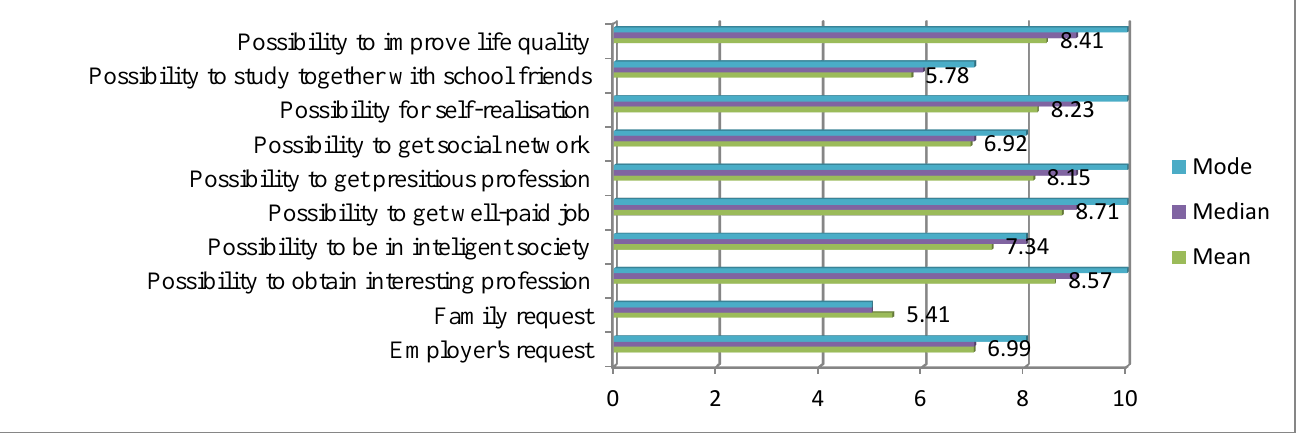
Fig. 1. Secondary school student evaluations of the most important aspects in acquiring higher